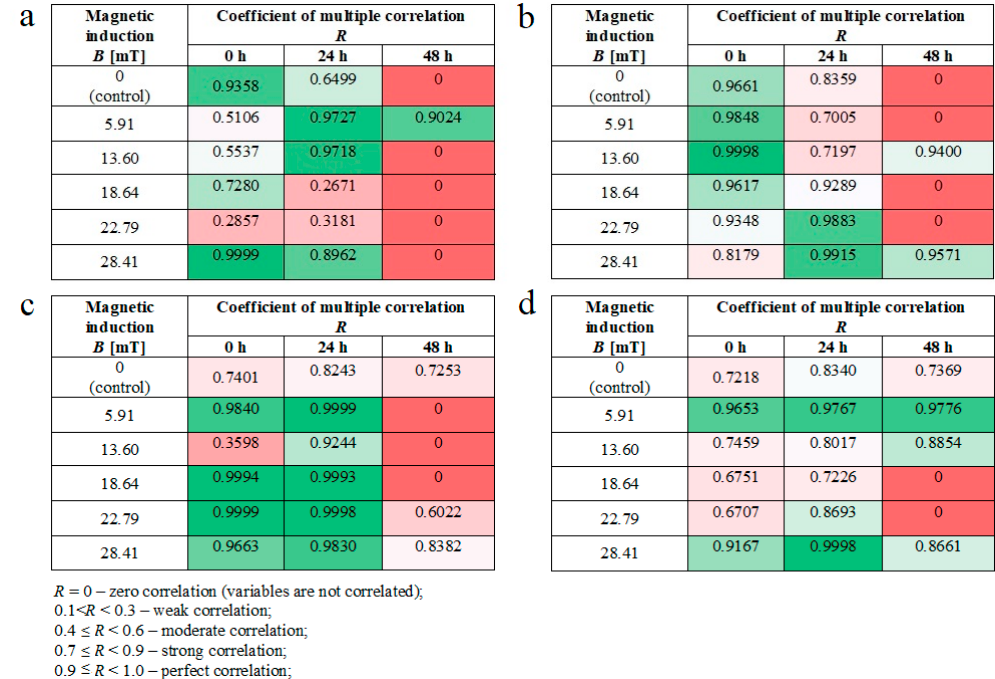
Figure 7. The values of correlation coefficients for L929 and RMF at frequency equal to 30 Hz ( a ); for L929 and RMF at frequency equal to 50 Hz ( b ); for HaCaT and RMF at frequency equal to 30 Hz ( c ); for HaCaT and RMF at frequency equal to 50 Hz ( d ). Differneces in correlation represented by different colors: zero correlation–dark red; weak correlation–red; moderate correlation–light red; strong correlation–light green; perfect correlation–dark green.